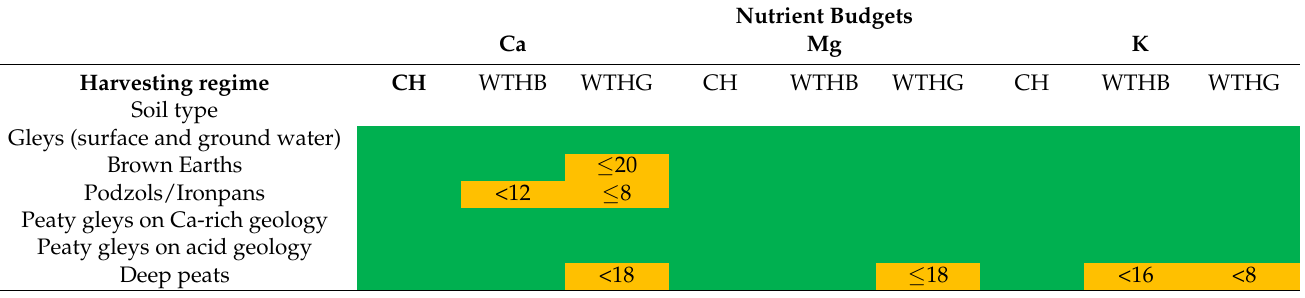
Table 6. Biomass removal decision matrix. The numbers represent forest Yield Class. A traffic light approach is adopted for each of three harvesting scenarios, comprising CH, WTHB and WTHG. Green represents a positive nutrient budget and therefore ‘go’ and orange a variable budget with the decision subject to site Yield Class, with ‘go’ if equal or less than the Yield Class threshold and ‘no go’ if greater than the Yield Class threshold. Nutrient Budgets Ca Mg K CH WTHB WTHG CH WTHB WTHG CH WTHB